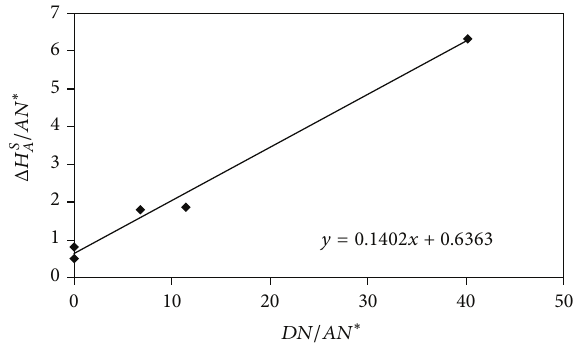
Figure 6: The plot of −Δ𝐻 𝑆 𝐴 / AN ∗ versus DN / AN ∗